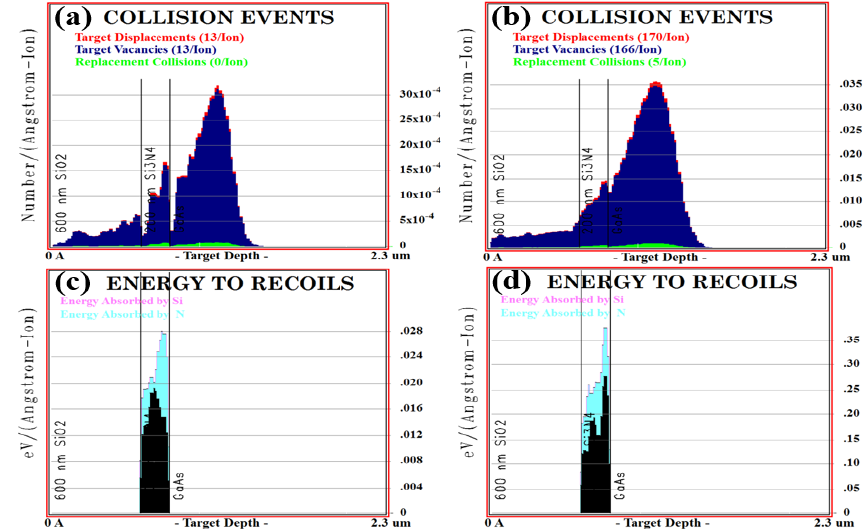
Figure 7. Damage due to H + and He + implantation into the SiO 2 / Si 3 N 4 / GaAs wafer calculated by SRIM. ( a ) Vacancies and defects caused by implantation with only H + into the SiO 2 / Si 3 N 4 / GaAs wafer; ( b ) Vacancies and defects caused by implantation with only He + into the SiO 2 / Si 3 N 4 / GaAs wafer; ( c ) The energy absorbed by N and Si atoms in the Si 3 N 4 layer when only H + was implanted; ( d ) The energy absorbed by N and Si atoms in the Si 3 N 4 layer when only He + was implanted.